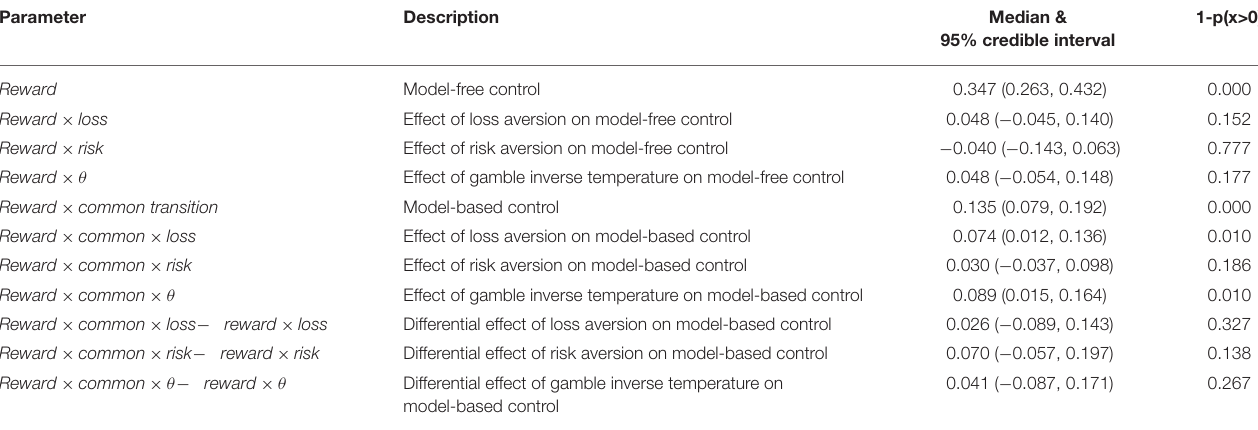
TABLE 3 | Group level estimates of model-based and model-free control in the two-step task, and the effects of the gambling task